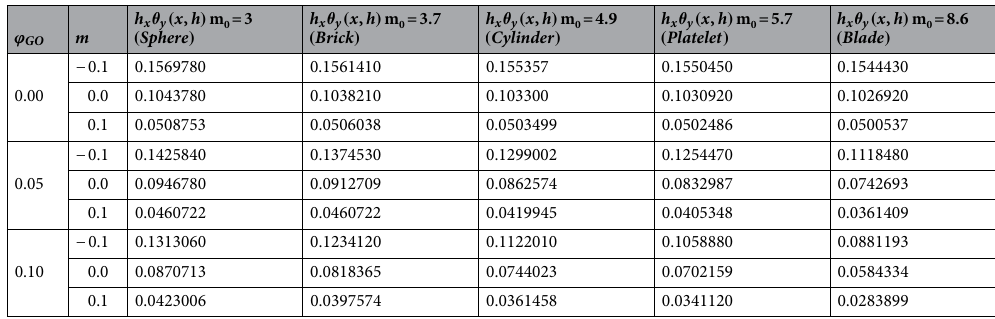
Table 5. Heat transfer rate z = ηθ y at wall for P-nano fluid and P-GO hybrid nanofluid varying (non-uniformity) convergent/uniform/divergent channel over shape effect fixing values M = 1, x = 0.3, Q = 0.3, β = 0.2, γ = 0.3, φ = 0.1, B r = 0.4, ϕ P = 0.1.